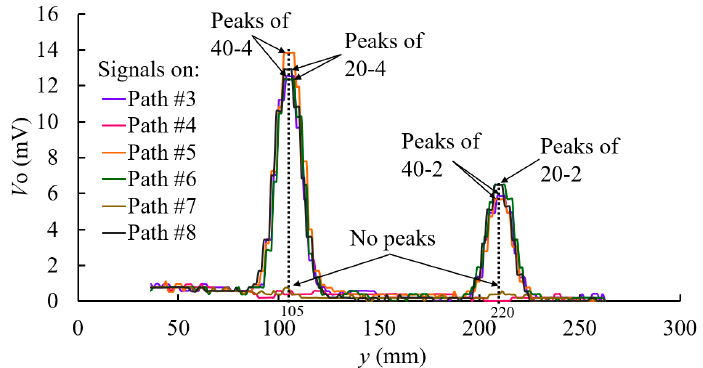
Figure 14. Measurement results of the butterfly probe on the test piece along paths #3–#6.